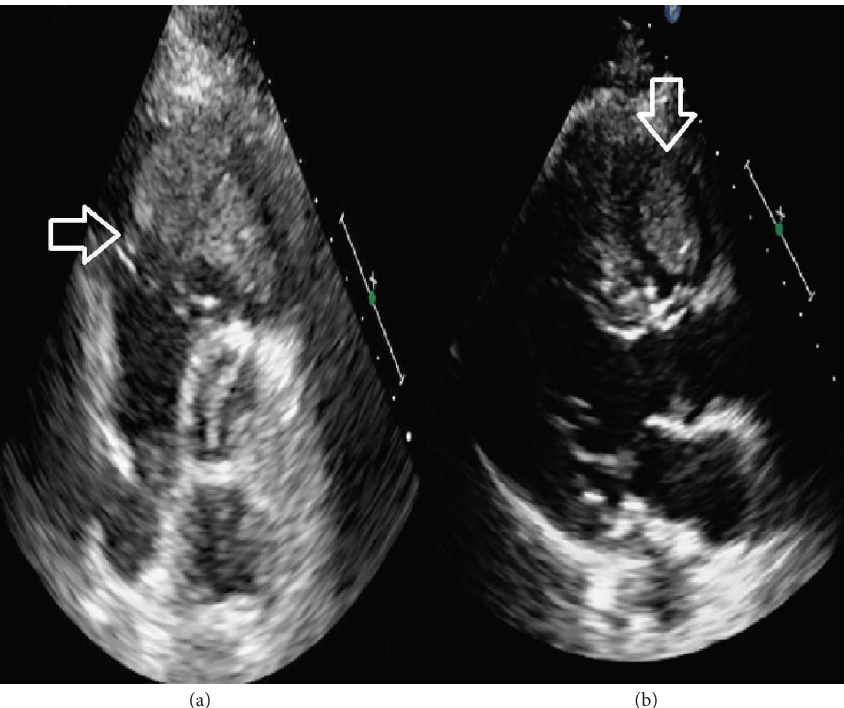
Figure 1: Transthoracic echocardiogram showing RV mass. (a) Parasternal short axis view demonstrates the mass (white arrow) extending from the undersurface of the tricuspid annulus and traversing the pulmonic valve. (b) Redemonstration of RV mass (white arrow) in the parasternal long axis view. Abbreviations: RV: right ventricle.